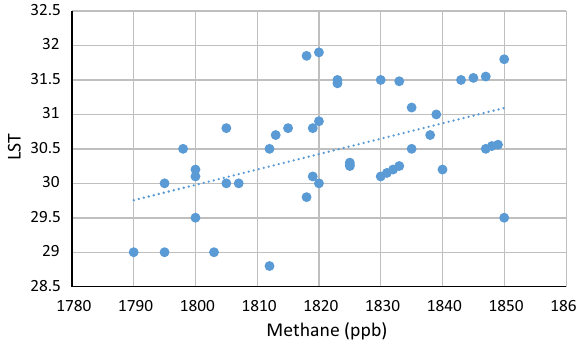
Fig. 12 Relationship between methane and LST in autumn